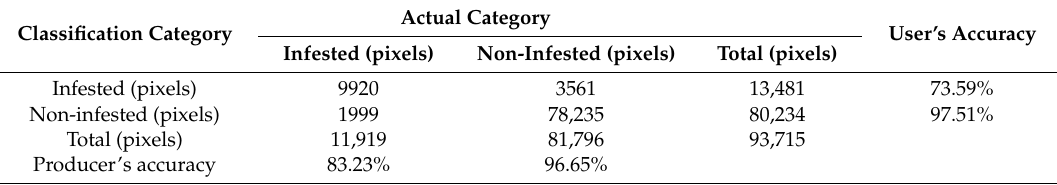
Table 3. Error matrix for classification map generated by field subset Sentinel-2A images for 24 cotton fields.